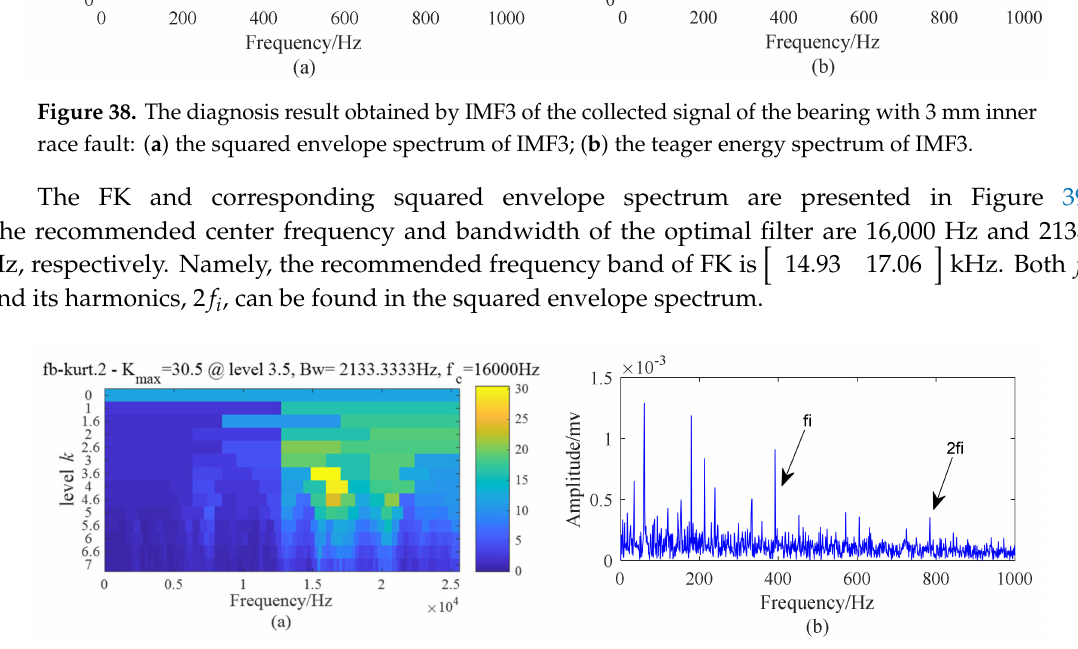
Figure 39. The diagnosis result of the collected signal of the bearing with 3 mm inner race fault processed by the Fast Kurtogram (FK) method: ( a ) the kurtogram result; ( b ) the squared envelope spectrum result.